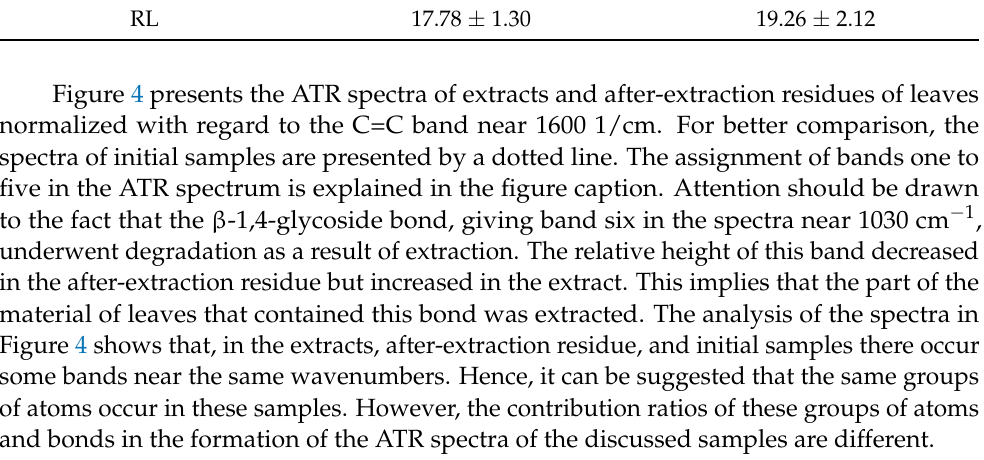
Yield of Extract Calculated from the Mass of the After-Extraction Residue